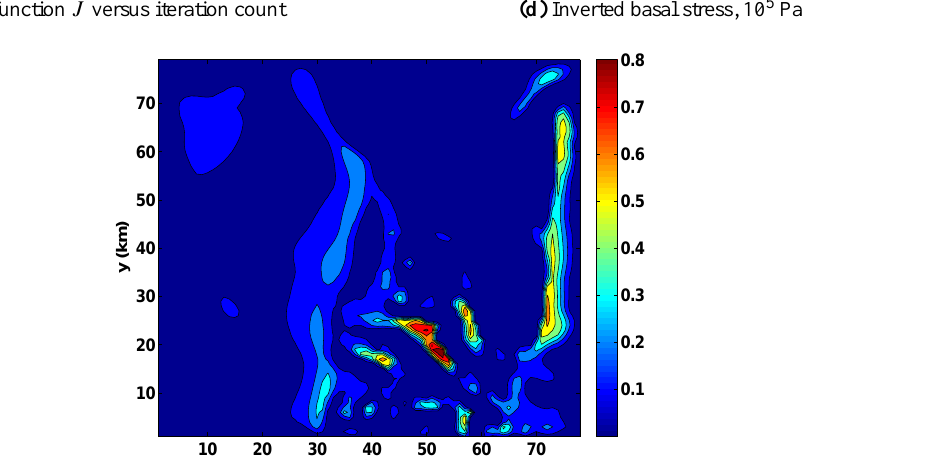
1 − 1 ) − 1 2 ( m a 2 . (e) The relative importance of vertical